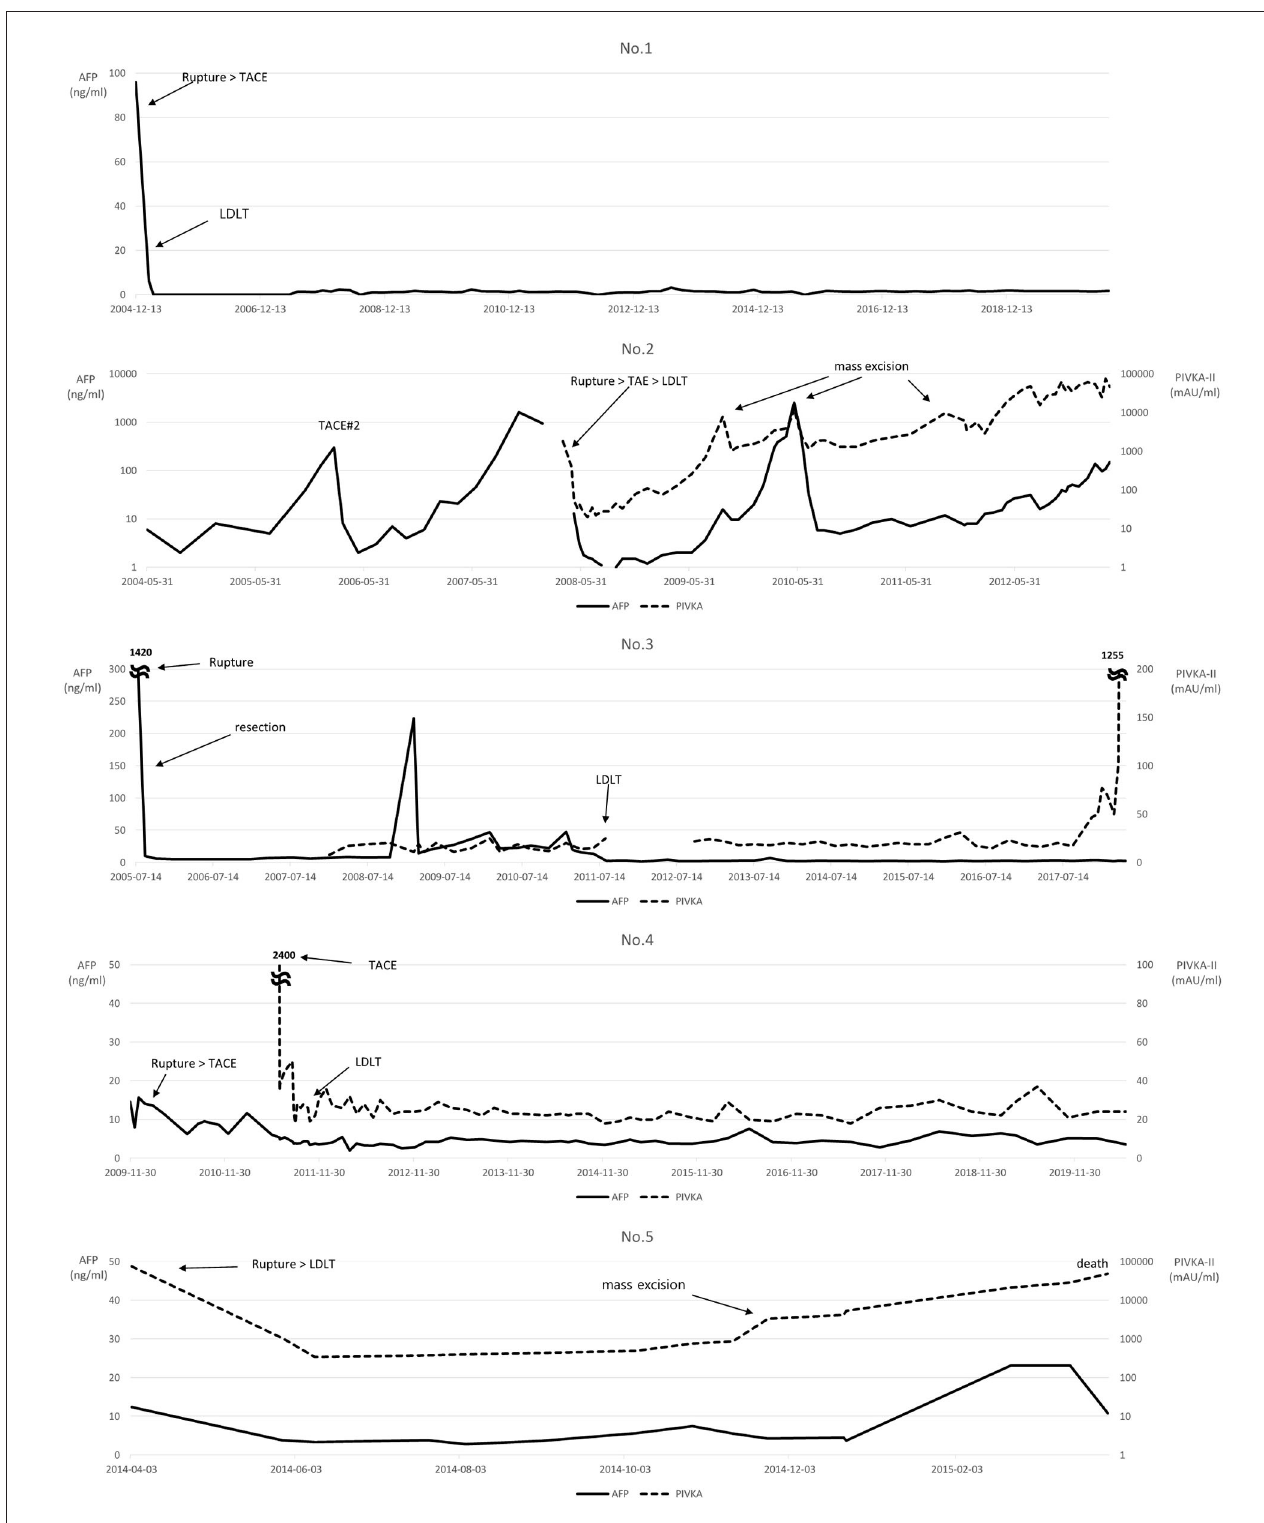
FIGURE 3 | Changes in the levels of serum alpha-fetoprotein (AFP) and protein induced by vitamin K absence or antagonist-II (PIVKA-II).